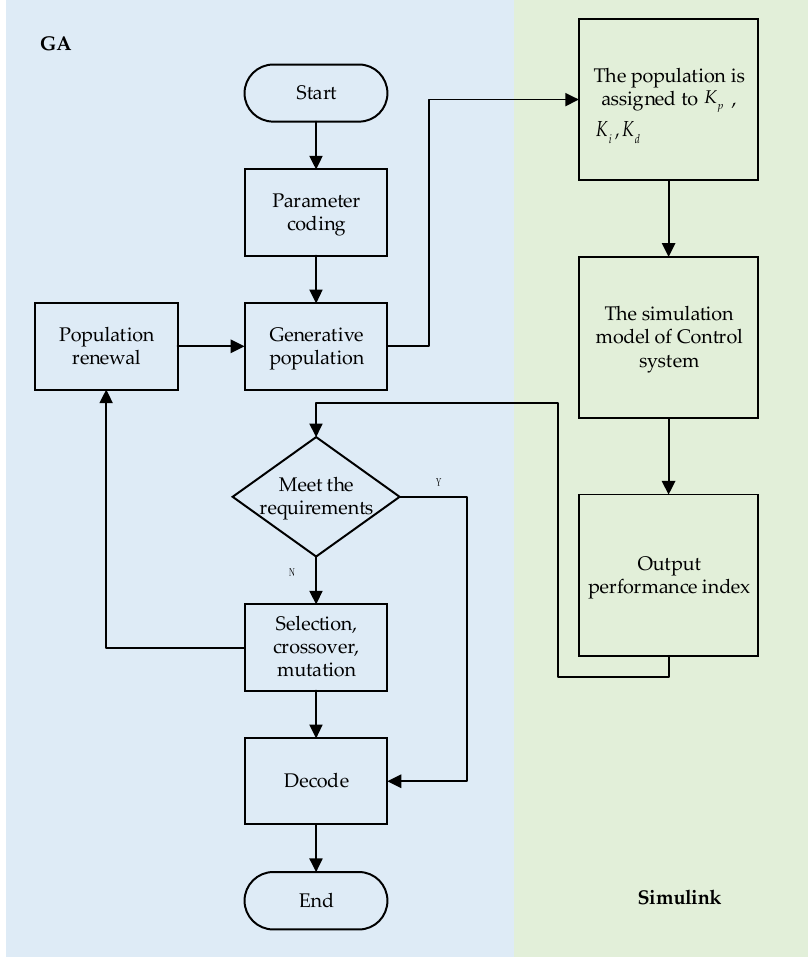
Figure 6. Schematic diagram of GA-tuning PID parameters.